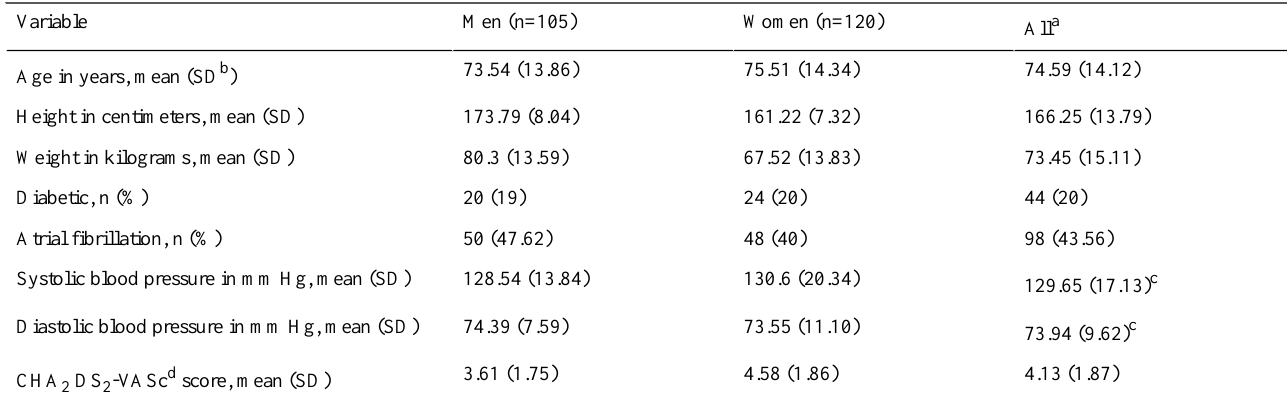
a Demographics of 4 patients were reported as missing data. b SD: standard deviation.Systolic and diastolic blood pressure were not included for patients who underwent the sport session. d CHA2DS2-VASc calculates the stroke risk for patients with atrial